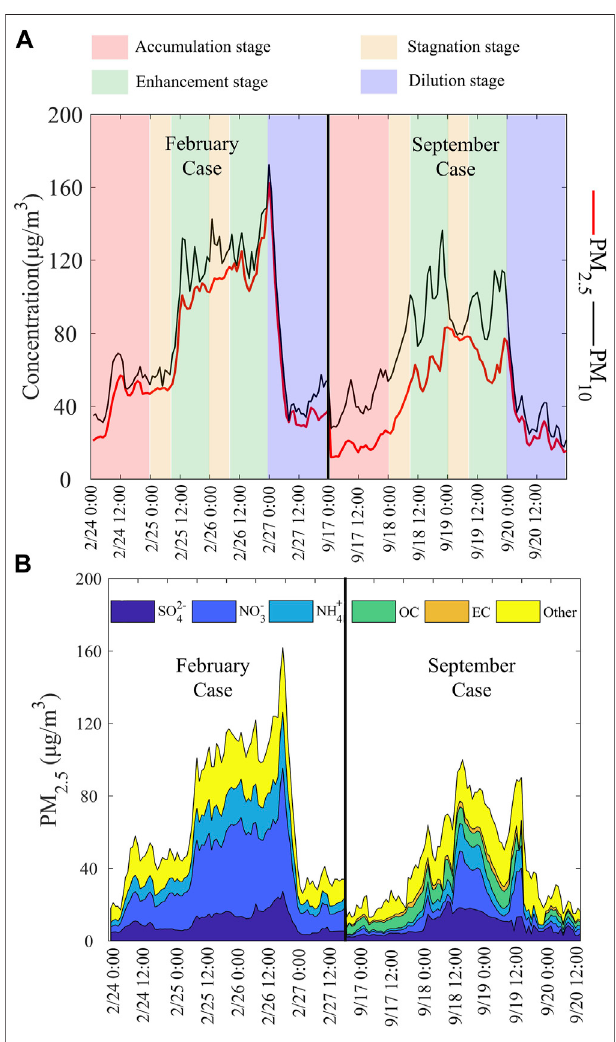
FIGURE 5 | Concentration of particulate matter in Shanghai (A) and the components of PM 2.5 in Pudong Monitoring Station (B) during two stable cases in